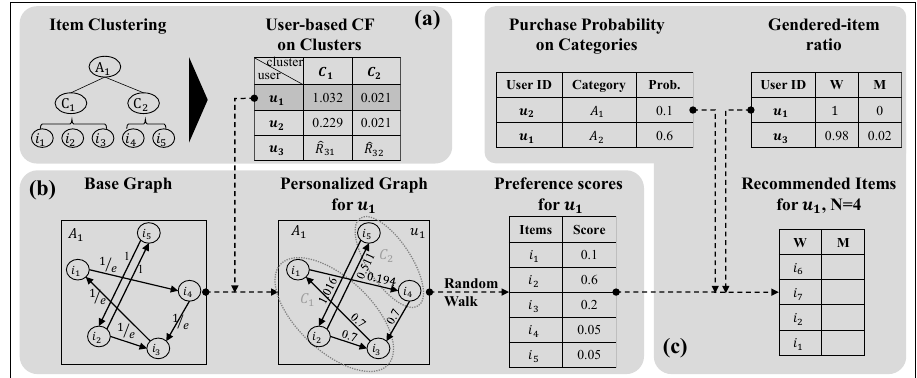
Figure 2. Overview of the proposed recommendation framework. ( a ) Clustering items and rating item clusters. ( b ) Scoring item preferences. ( c ) Reflecting user’s needs. Table 1. An example of user activity log.